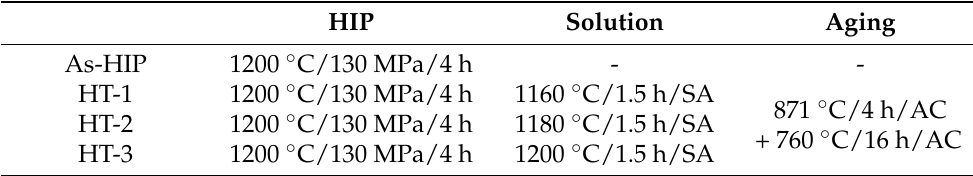
Table 2. The preparation process for the P/M superalloy